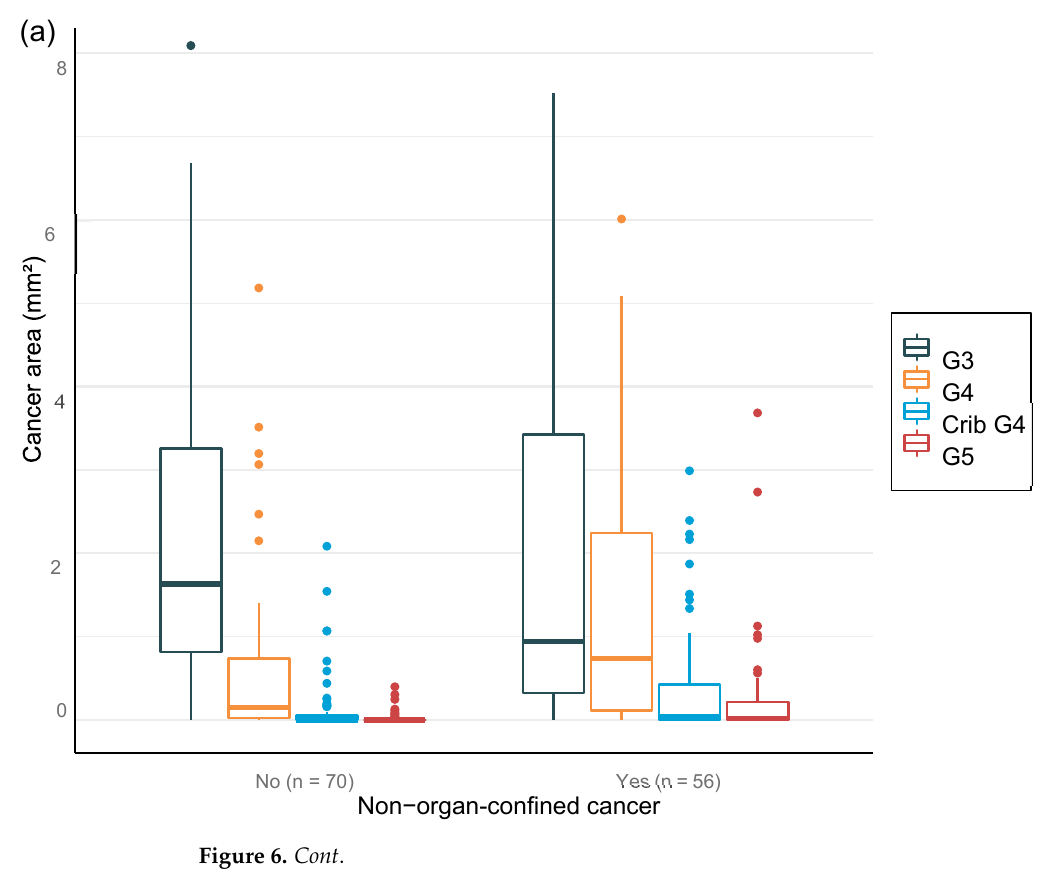
The value of AI in predicting adverse cancer extent after surgery was analyzed for the total area. Moreover, the proportion of cancer detected by AI per biopsy session was plotted against the adverse pathological findings at prostatectomy (Figure 6).